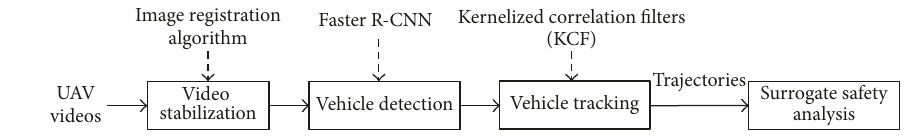
Figure 1: The workflow of vehicle detection and tracking.